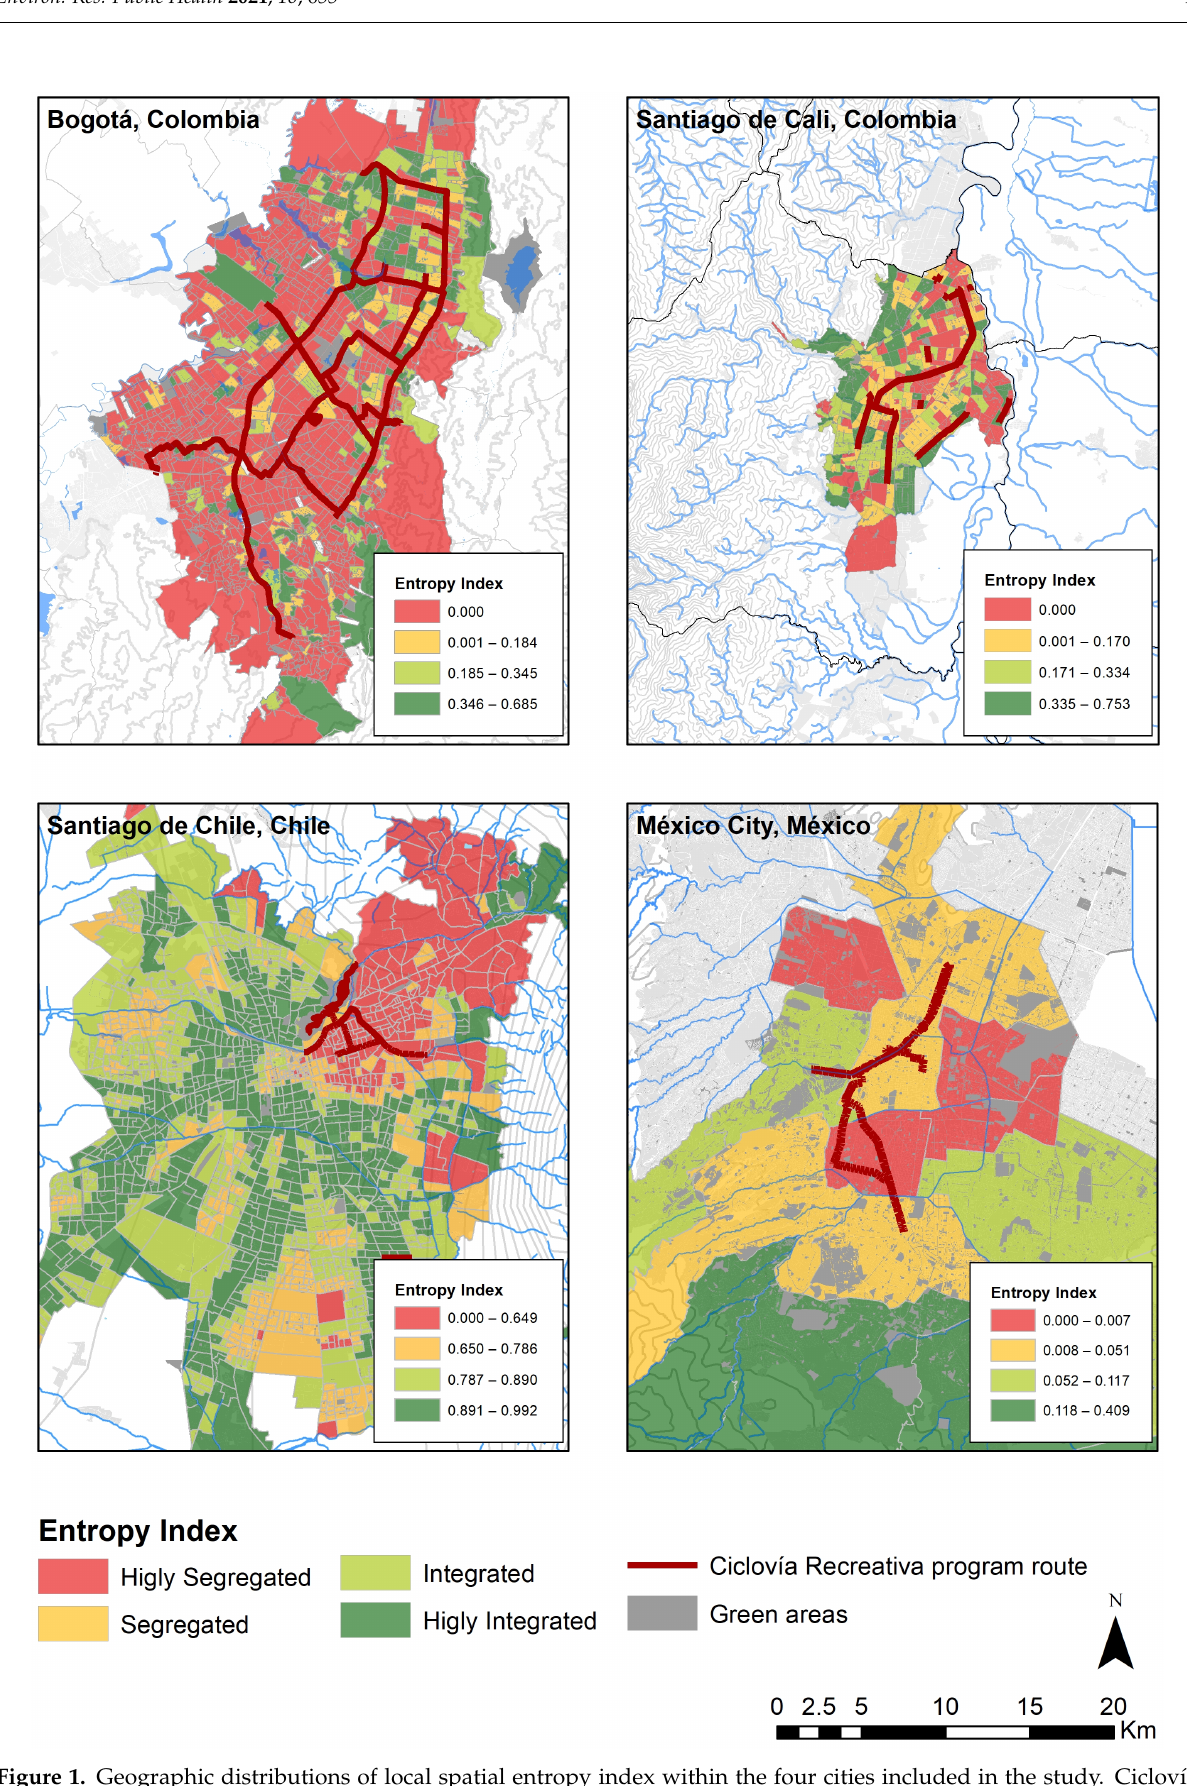
Figure 1. Geographic distributions of local spatial entropy index within the four cities included in the study. Ciclov í a Recreativa program routes and green areas in each city are also